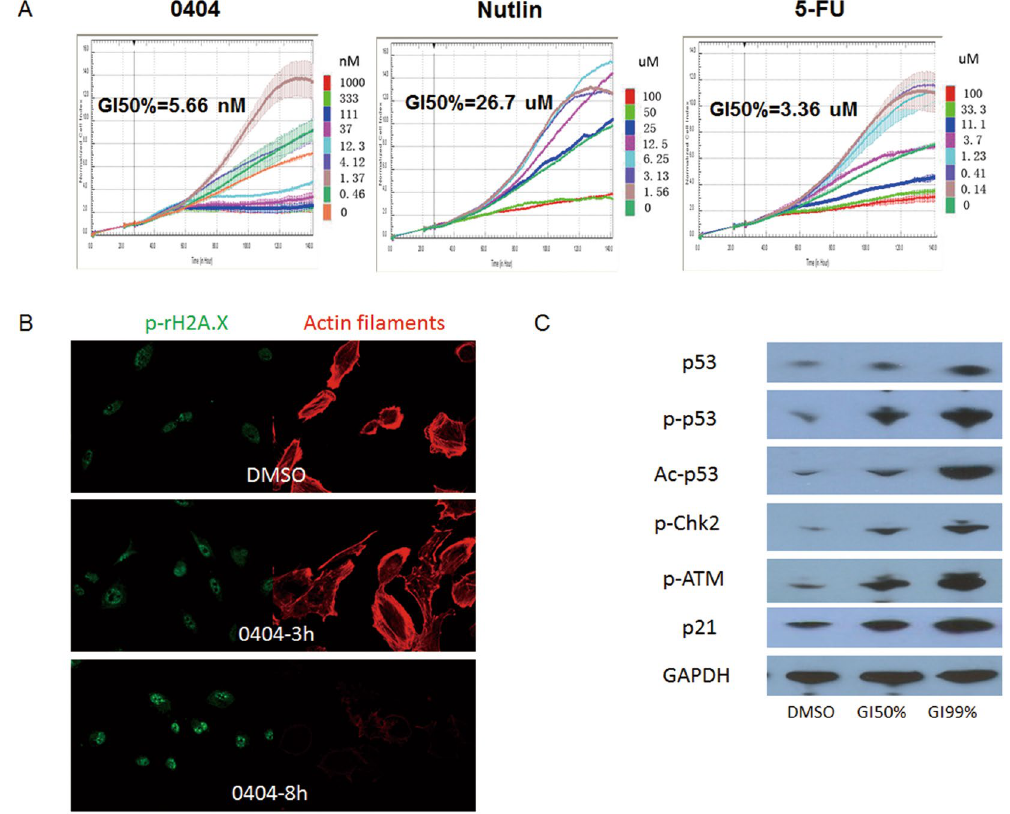
Figure 1. Screening of 0404 as a new DNA-damaging compound using TCRP. ( A ) 0404 was more effective than classical DNA-damaging agent as it could induce significant growth inhibition of H292 cells at nM concentration. ( B ) 0404 up-regulated p- γ H2A.X level in a time-depended manner. ( C ) The expression of DNA damage-related signaling molecules was significantly up-regulated in 0404-treated A549 cells in a concentration-dependent